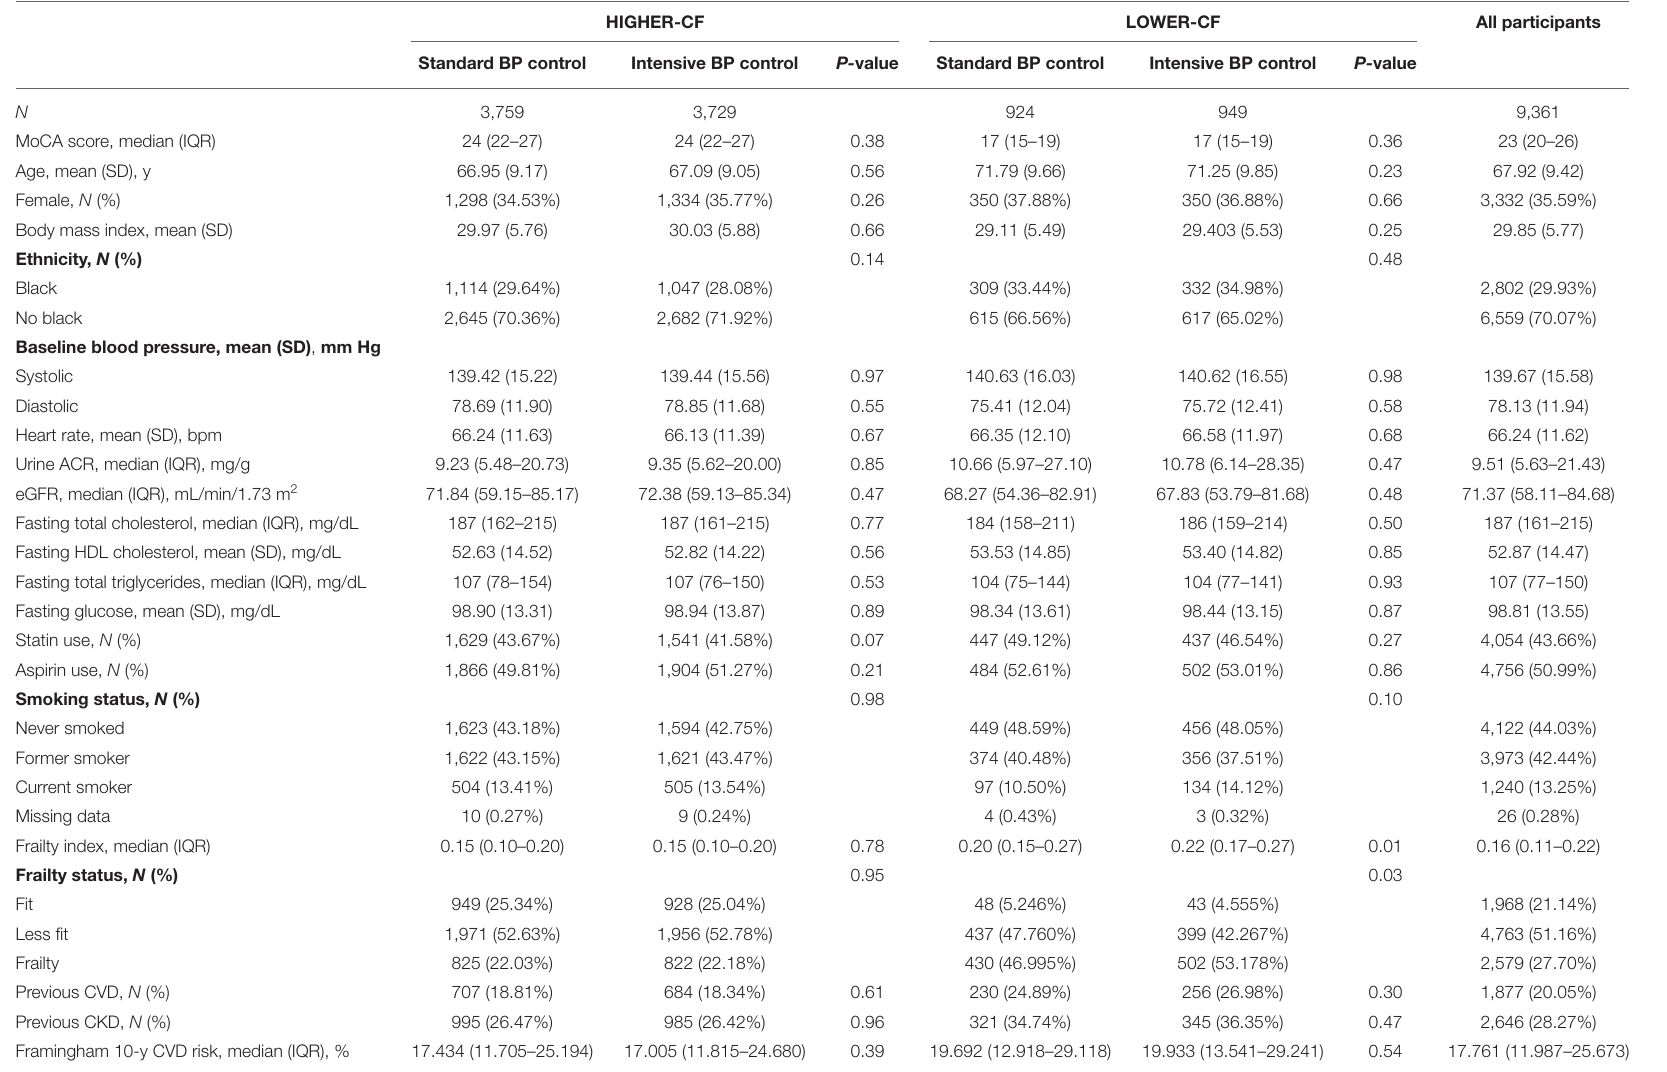
TABLE 1 | Baseline characteristics and outcomes of the study participants according to baseline cognitive function. HIGHER-CF